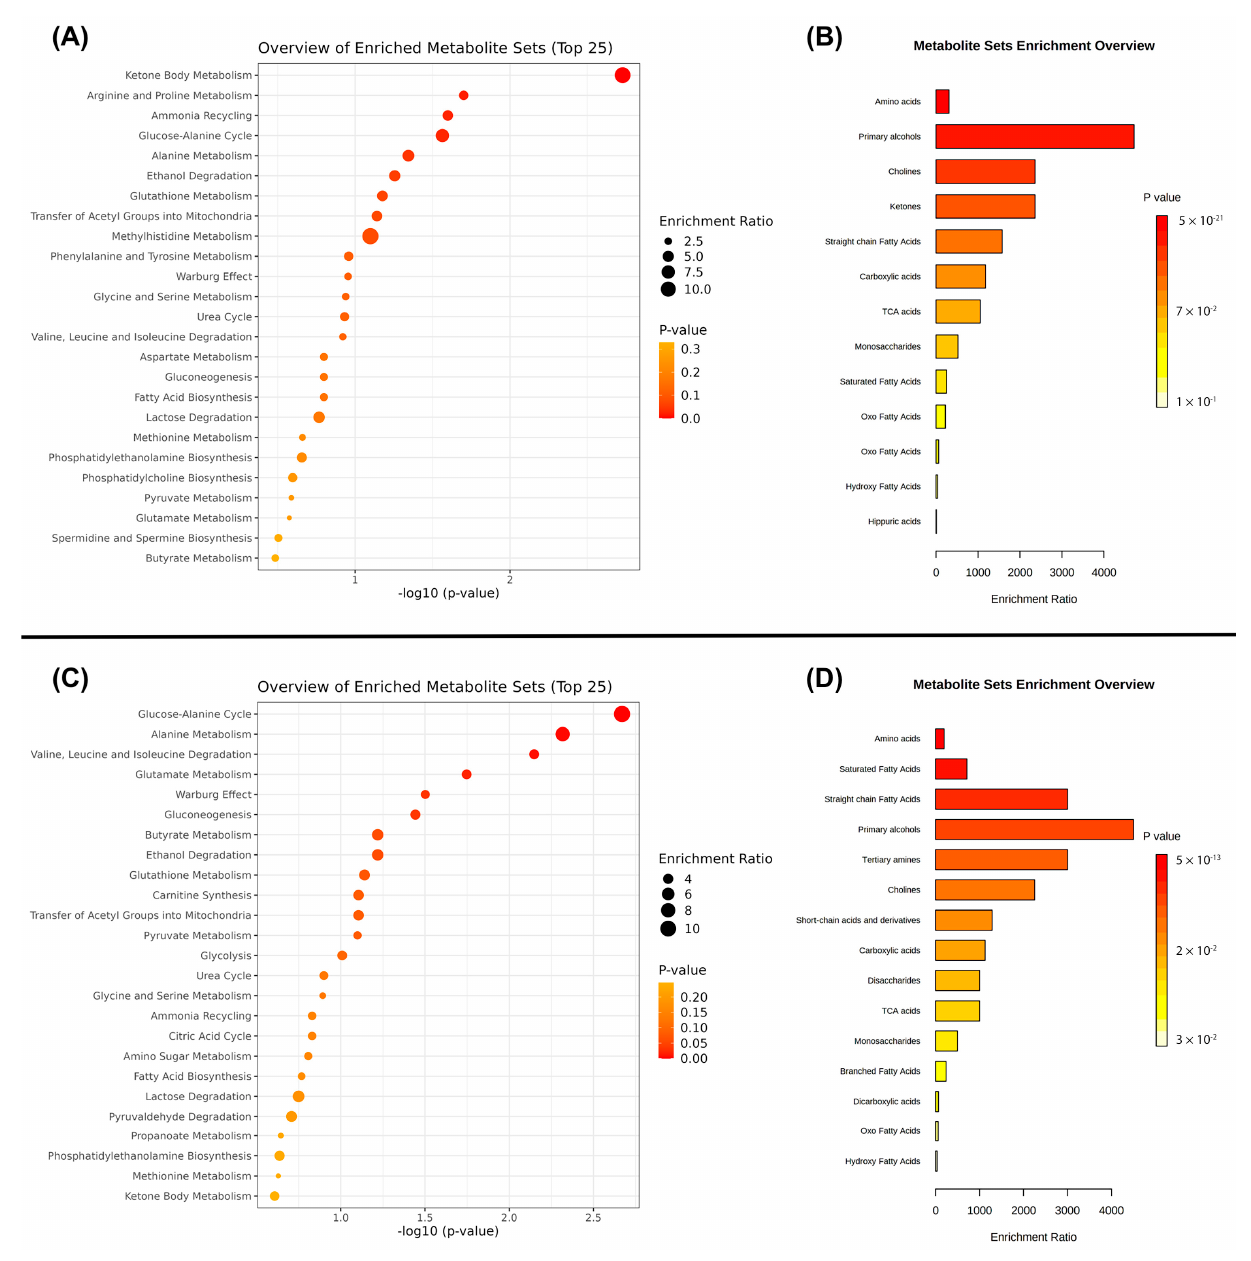
Figure 5. Main pathways and subclasses assigned by MSEA for plasma ( A , B ) and saliva ( C , D ) samples.